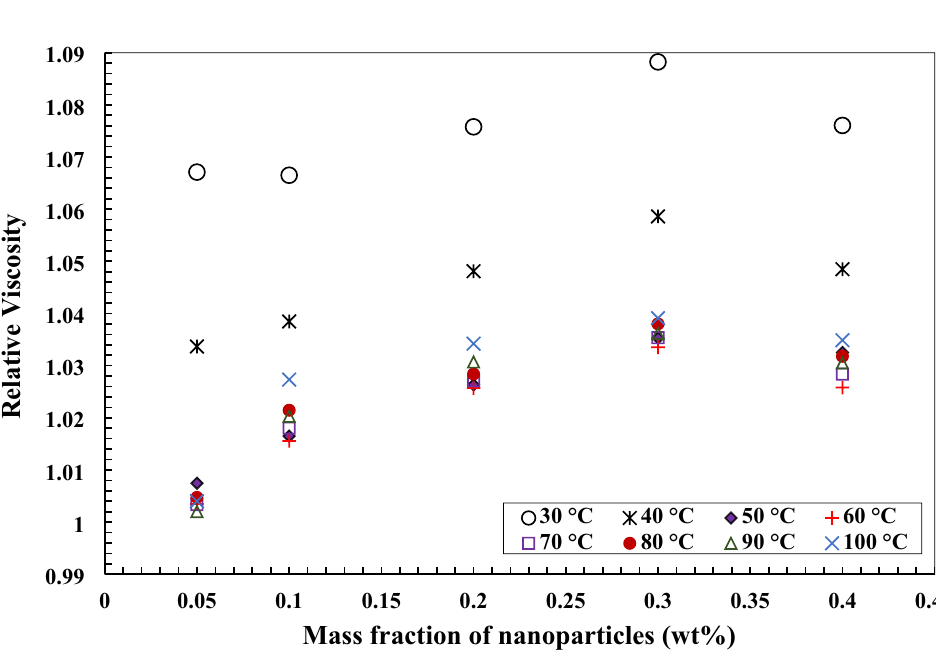
Figure 13. Variation of relative viscosity of MWCNTs/turbine meter nanofluids in different mass